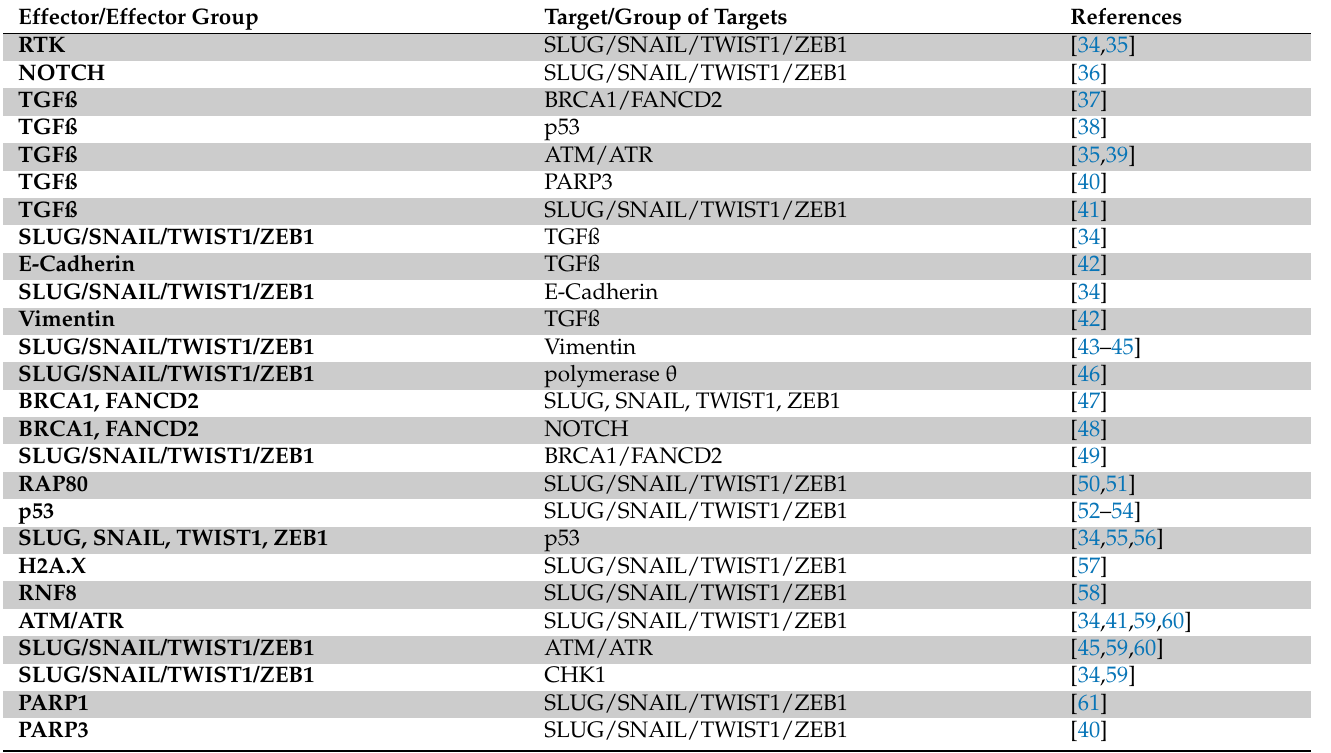
Table 1. Effectors and targets of the signaling network connecting DNA damage responses and epithelial-mesenchymal transition (EMT) in breast cancer